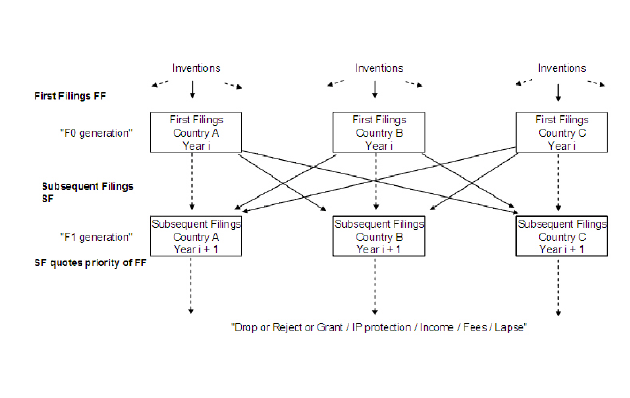
Fig. 1. Structure of patenting in terms of a generation of first filings, followed by subsequent filings up to one year later.